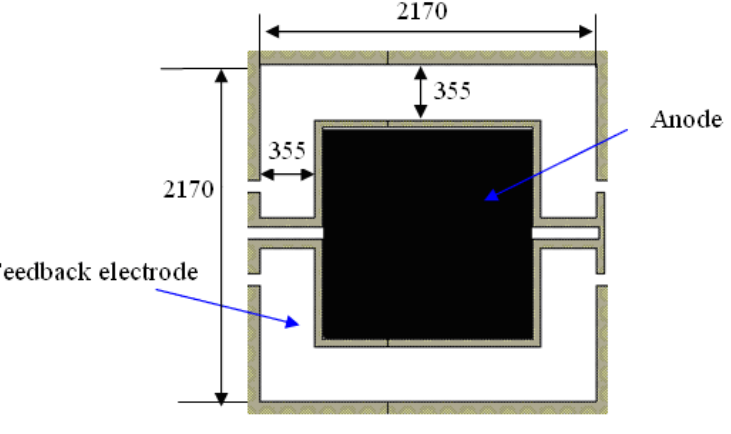
Figure 3. Bottom electrode of vacuum microelectronic